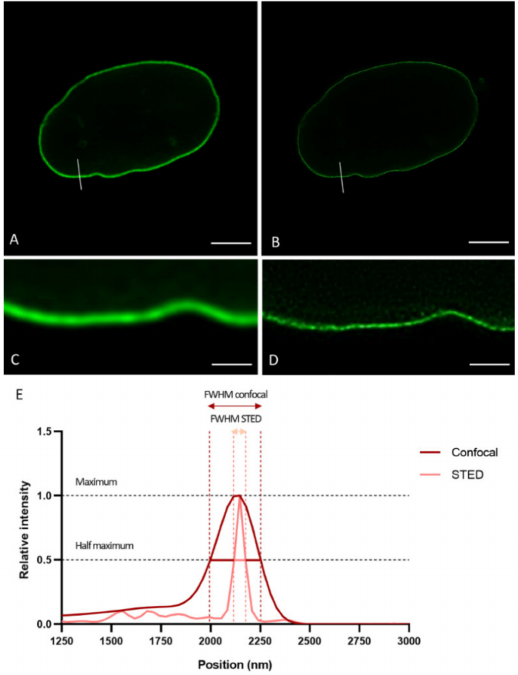
Figure 1. Confocal laser scanning microscopy ( A ) and STED microscopy ( B ) images of nHDF stained with antibodies against lamin B1. The region of interest (ROI) is used for the plot profile displayed in ( E ). Scale bars: 5 µ m. ( C , D ) Higher magnification (5 × ) of the region around ROIs in ( A , B ). Scale bars: 1 µ m. ( E ) Plot profile of lamin intensity, normalized to maximum value. The Full-Width Half Maximum (FWHM) (i.e., the width of the peak at half of its maximum value) of STED (pink) and confocal laser scanning microscopy (red) is